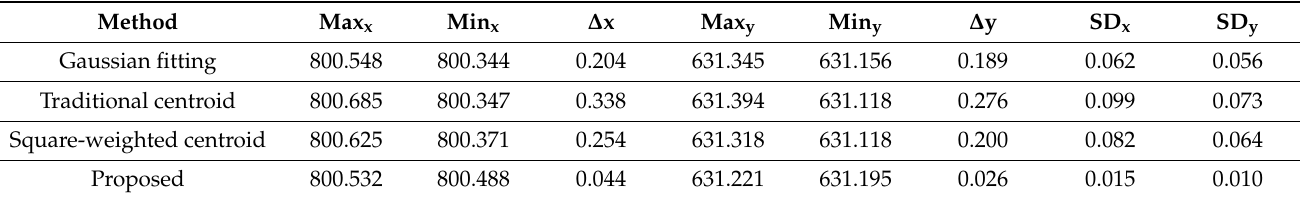
Table 3. Analysis and comparison of different algorithm